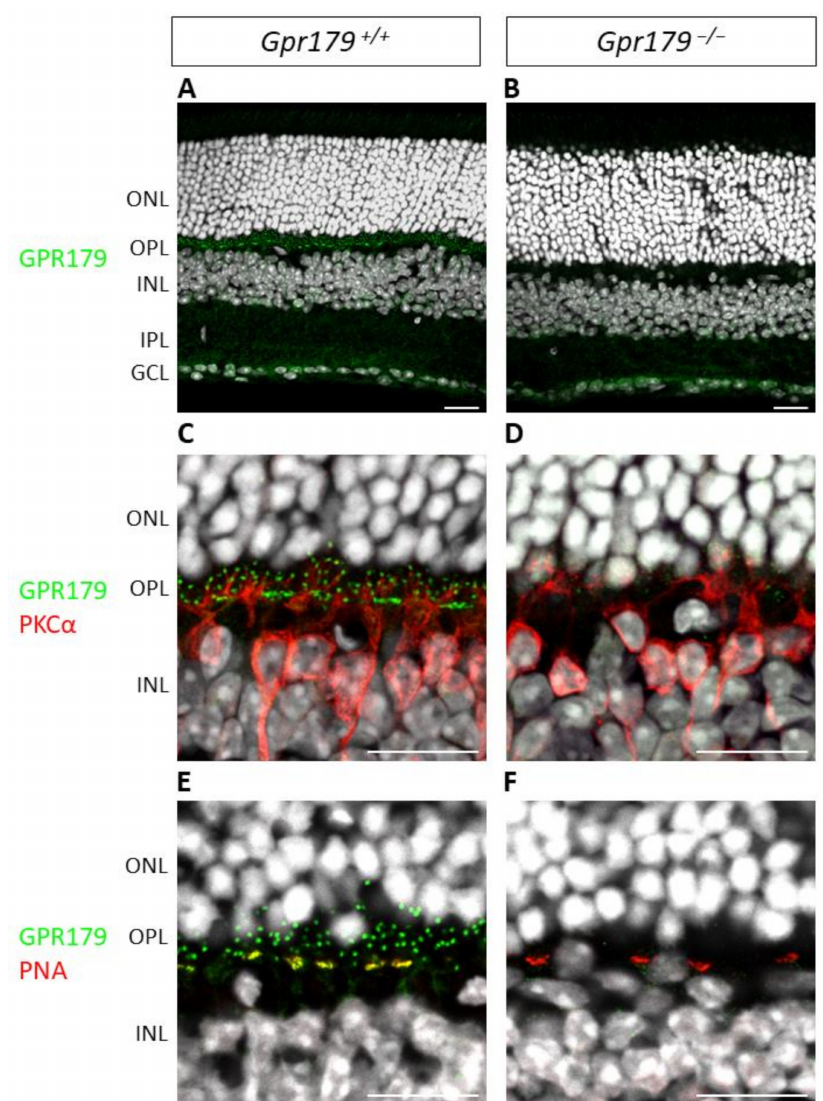
Figure 6. Validation of Gpr179 knock-out model. Representative confocal images of Gpr179 +/+ and Gpr179 − / − mouse retinal sections. Gpr179 +/+ ( A ) and Gpr179 − / − ( B ) mouse retinal sections were stained with anti-GPR179 (green) and DAPI (white). ( C , D ) are shown with a 4 × zoom focused on the outer plexiform layer (OPL) of ( A , B ), with additional staining of rod ON-bipolar cell specific marker PKC α (red). ( E , F ) are focused images of OPL of Gpr179 +/+ ( E ) and Gpr179 − / − ( F ) mouse retinal sections stained with anti-GPR179 (green), anti-PNA which is a marker of cone pedicle (red), and DAPI (white). Scale bar: 10 µ m, ONL: outer nuclear layer; OPL: outer plexiform layer; INL: inner nuclear layer; IPL: inner plexiform layer; GCL: ganglion cell